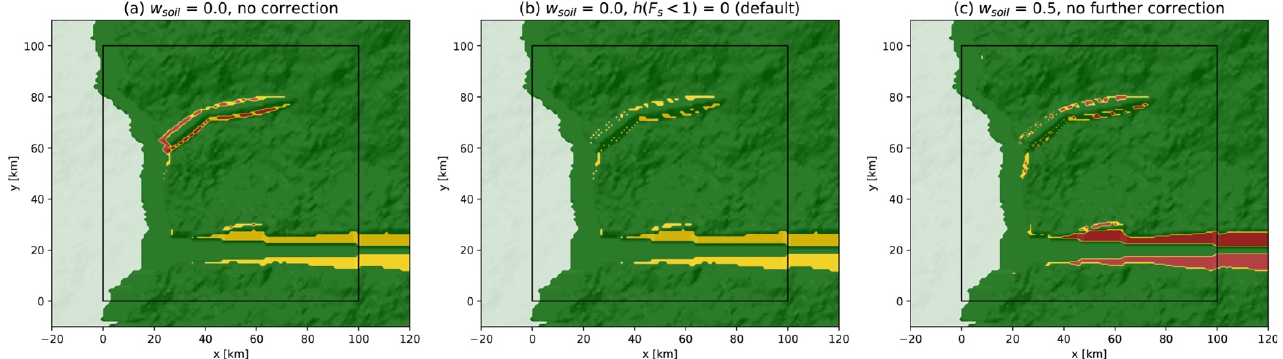
Figure 6. Factor-of-safety maps: ( a ) h ( x , y ) = h 0 = 10 m and w soil = 0; ( b ) Default parameterization with correction h ( x , y | F s < 1 ) = 0 m; ( c ) Extreme case with w soil = 0.5 and no further change in h ( x , y ) . Stable ( F s > 1.5 ), critical (1 ≤ F s ≤ 1.5 ), and unstable ( F s < 1 ) areas are represented in green, yellow, and red, respectively. Large unstable areas are considered unrealistic in the soil layer prior to the generation of any event.